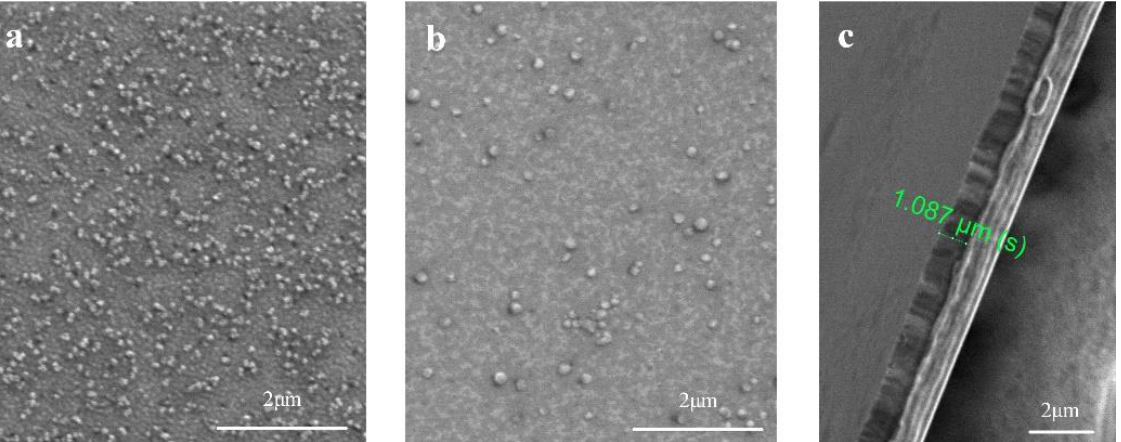
Figure 1. Surface morphology of Cu-Ta alloy films. ( a ) The surface of Cu84Ta16 (where 84 represents the atom concentration of Cu is 84%); ( b ) The surface of Cu3.5Ta96.5; ( c ) The thickness of Cu-Ta alloy film (where the sample is Cu84Ta16).